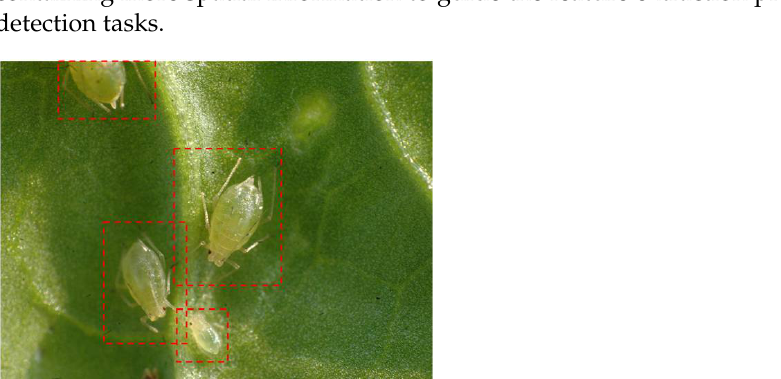
11 of 22 Figure 5. Comparison of (cid:1871)(cid:1875)(cid:1861)(cid:1871)ℎ and ℎ(cid:1853)(cid:1870)(cid:1856) - (cid:1871)(cid:1875)(cid:1861)(cid:1871)ℎ function curves. This study adopts the above-described group convolution, channel shuffle, and ℎ(cid:1853)(cid:1870)(cid:1856) - (cid:1871)(cid:1875)(cid:1861)(cid:1871)ℎ activation function to build a lightweight sandglass block with better perfor- mance, fewer parameters and less computation, named LightSandGlass. The structure of LightSandGlass is shown in Figure 3d, where RGConv and EGConv denote the group pointwise convolution used for dimension reduction and dimension expansion. Consid- ering that too many group convolutions will increase the memory access consumption [36] and that ℎ(cid:1853)(cid:1870)(cid:1856) - (cid:1871)(cid:1875)(cid:1861)(cid:1871)ℎ performs better in deeper network layers, this study only re- places the residual blocks in the deep part of the network with LightSandGlass.